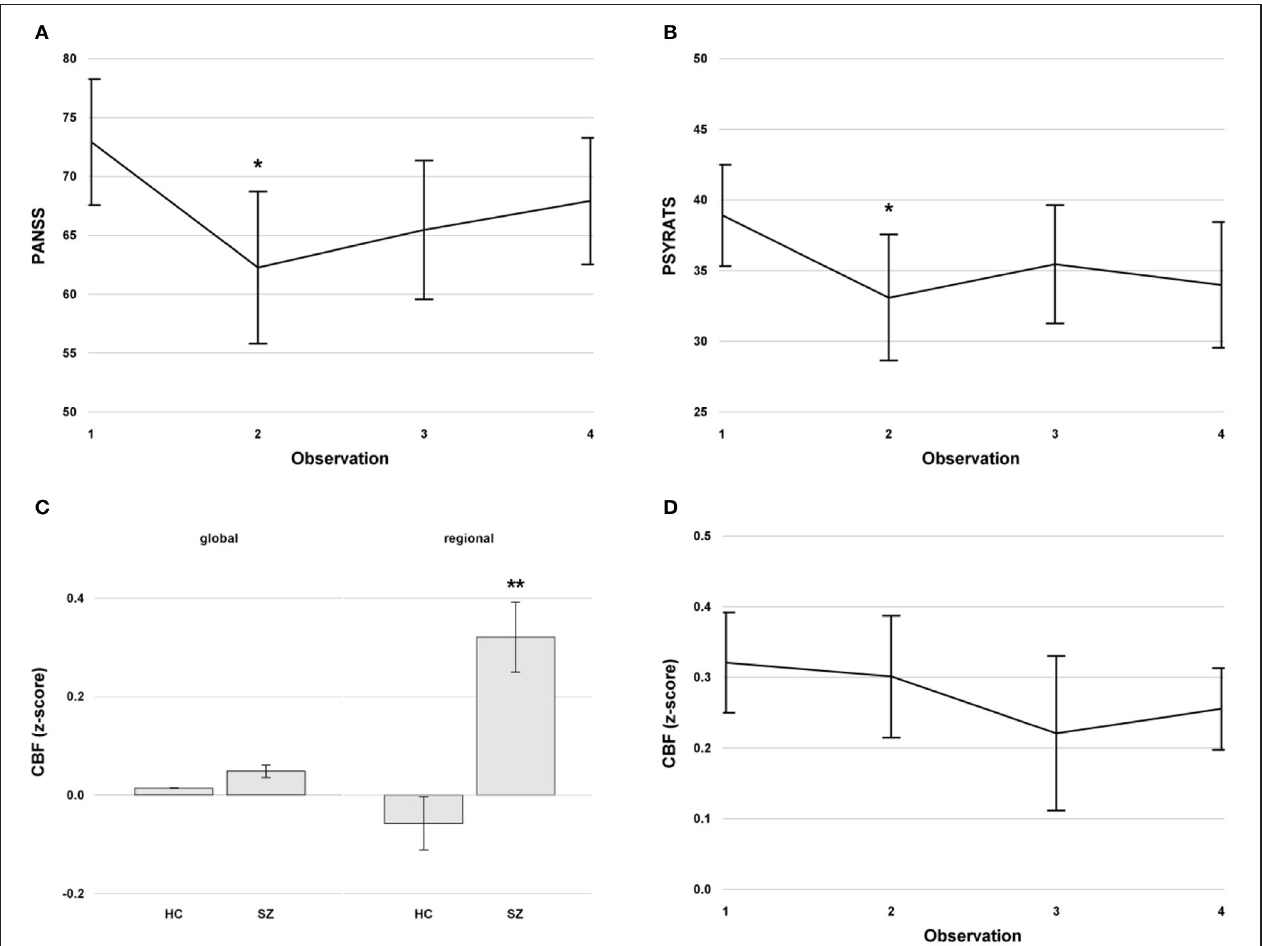
FIGURE 2 | (A) Mean PANSS scores with standard errors across time in the patients. (B) Mean PSYRATS scores with standard errors across time in the patients. (C) Mean global and regional cerebral blood flow (CBF) in the left superior temporal gyrus with standard error at baseline in healthy controls and patients with schizophrenia with persistent auditory verbal hallucinations. (D) Mean regional CBF with standard